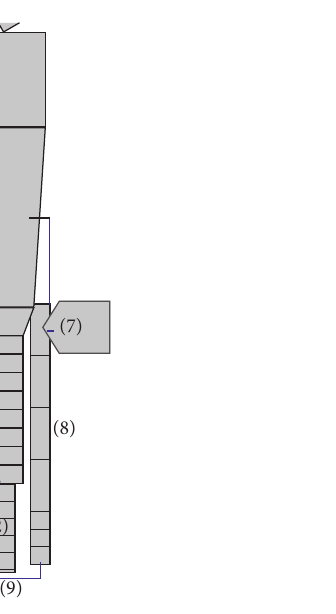
Figure 10: Thermal-hydraulic nodalization of 900MW CANDU steam generators close-up, showing (1) preheater, (2) lower boiler, (3) upper boiler, (4) steam riser, (5) steam drum with steam separators/dryers, (6) steam dome, (7) moisture separator drains, (8) downcomer, and (9) leakage